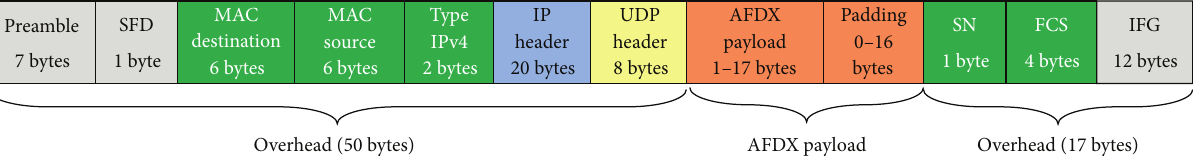
Figure 2: The AFDX frame structure and its